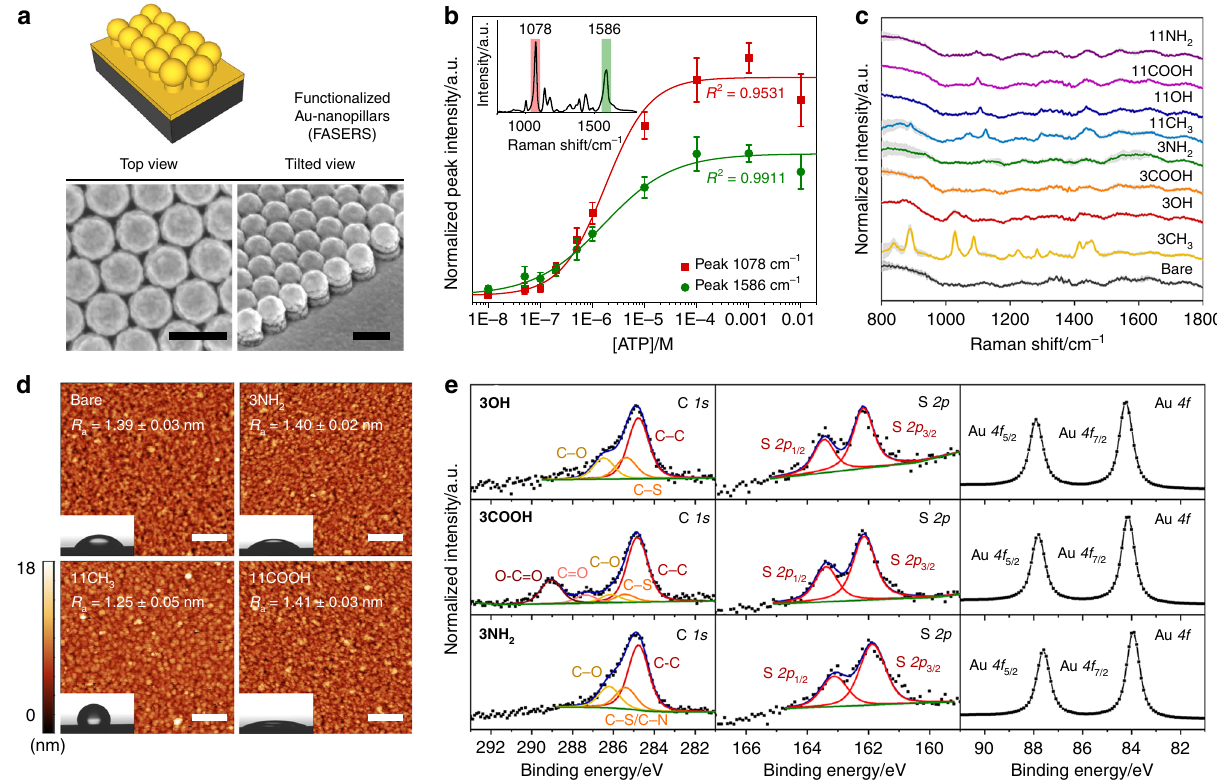
Fig. 2 Fabrication and characterization of FASERS substrates. a Schematic illustration and representative SEM images of gold fi lm-coated polystyrene beads (PS) – Si 3 N 4 (Au-nanopillars) SERS-active substrates that are used in FASERS. SEM images were obtained from top view and angled view from 45° tilted stage without extra metal coating. Scale bar, 400 nm. b Normalized SERS intensities of two prominent peaks of 4-aminothiophenol (ATP) with varying concentration on non-functionalized Au-nanopillars. Data represent mean ± 1 s.d. from nine obtained spectra ( N = 3, n = 3 spectra) and fi tted with a sigmoidal curve. Inset graph shows the mean of nine spectra from a 1 mM ATP solution. c SERS spectra of functionalized Au-nanopillars in PBS (10 mM, pH 7.4) with various SAM-forming molecules: non-functionalized (bare), 1-propanethiol (3CH 3 ), 3-mercapto-1-propanol (3OH), 3-mercaptopropionic acid (3COOH), 3-amino-1-propanethiol (3NH 2 ), 1-undecanethiol (11CH 3 ), 11-mercapto-1-undecanol (11OH), 11-mercaptoundecanoic acid (11COOH), 11-amino-1- undecanethiol (11NH 2 ). Solid lines and grey shaded area represent mean and ±1 s.d. of nine obtained spectra ( N = 3, n = 3 spectra). d Representative AFM images of several of the functionalized gold fi lm-coated Si wafers (Au – Si) with various SAM-forming molecules (from top-left to bottom-right): Bare, 3NH 2 , 11CH 3 , 11COOH. Scale bar, 400 nm. Average of the mean roughness (R a ) of each surface was noted in the image with ±1 s.d. ( n = 3 scans). Inset images indicate the range of water contact angles observed at each surface. e Representative high-resolution XPS spectra of C 1s , S 2p and Au 4f for 3OH (top), 3COOH (middle) and 3NH 2 (bottom) SAM-functionalized Au –